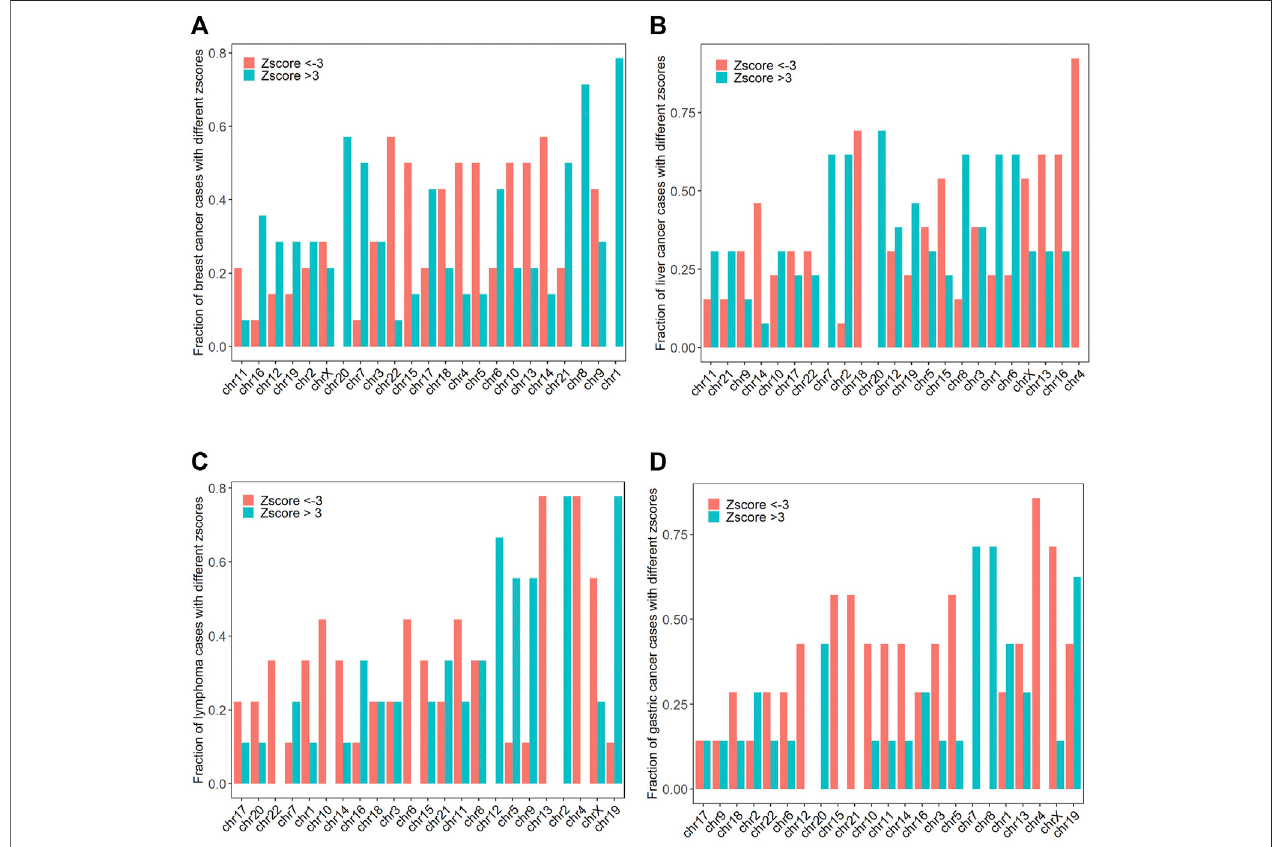
FIGURE 2 | The frequencies of chromosomal ampli fi cations (z score > 3) and deletions (z score < − 3) in breast cancer, liver cancer, lymphoma, and gastric cancer (A – D) .